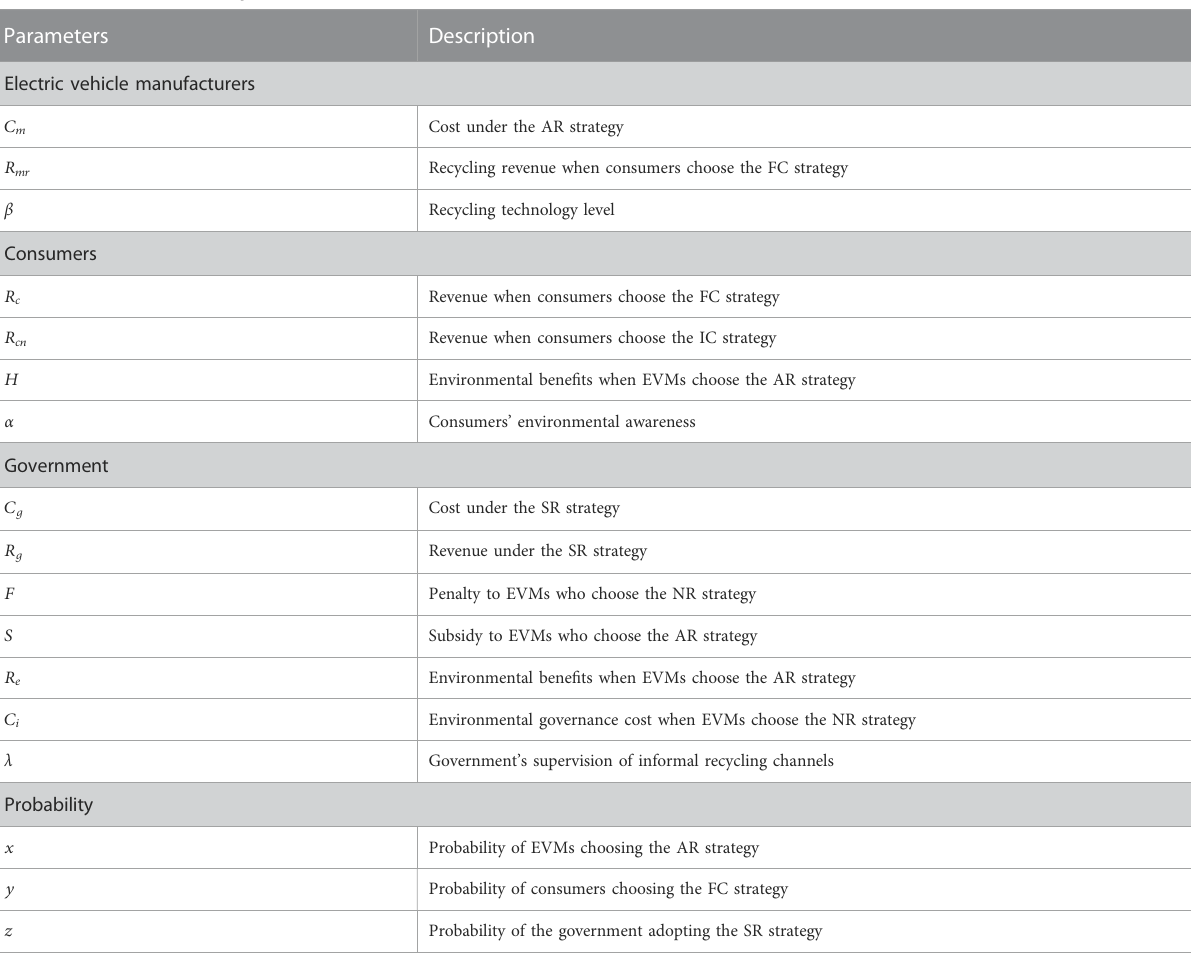
TABLE 1 Parameters and description.